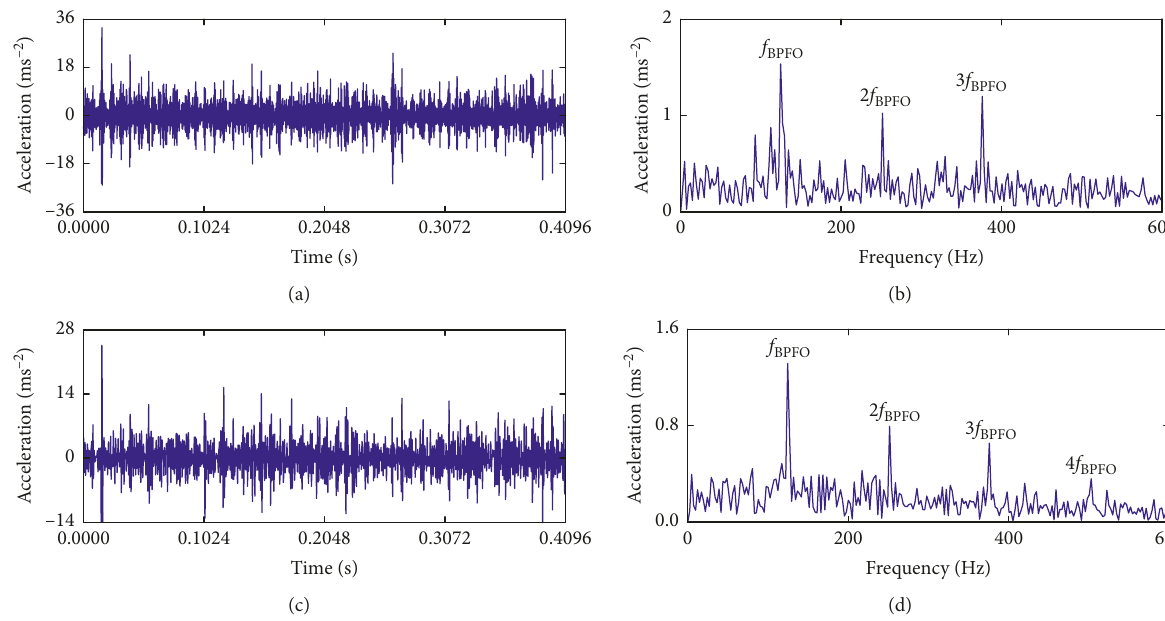
Figure 31: Processing results obtained using EEMD: (a) IMF1; (b) envelope spectra of IMF1; (c) IMF3; (d) envelope spectra of IMF3.